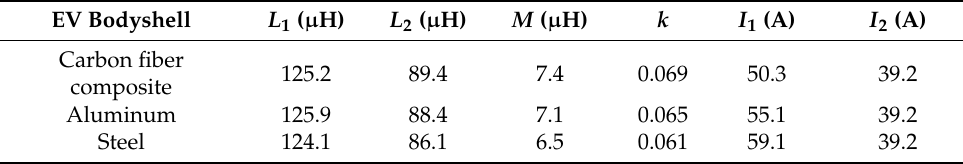
Table 2. WPT lumped inductances and r.m.s. currents at 85